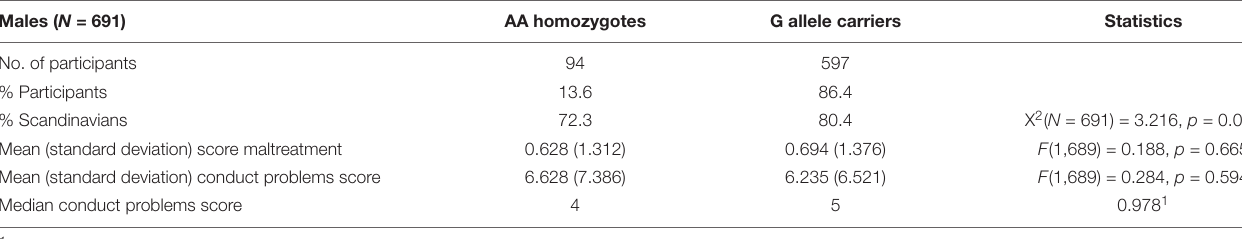
TABLE 1 | Comparisons of characteristics of AA homozygotes and G allele carriers among male participants.